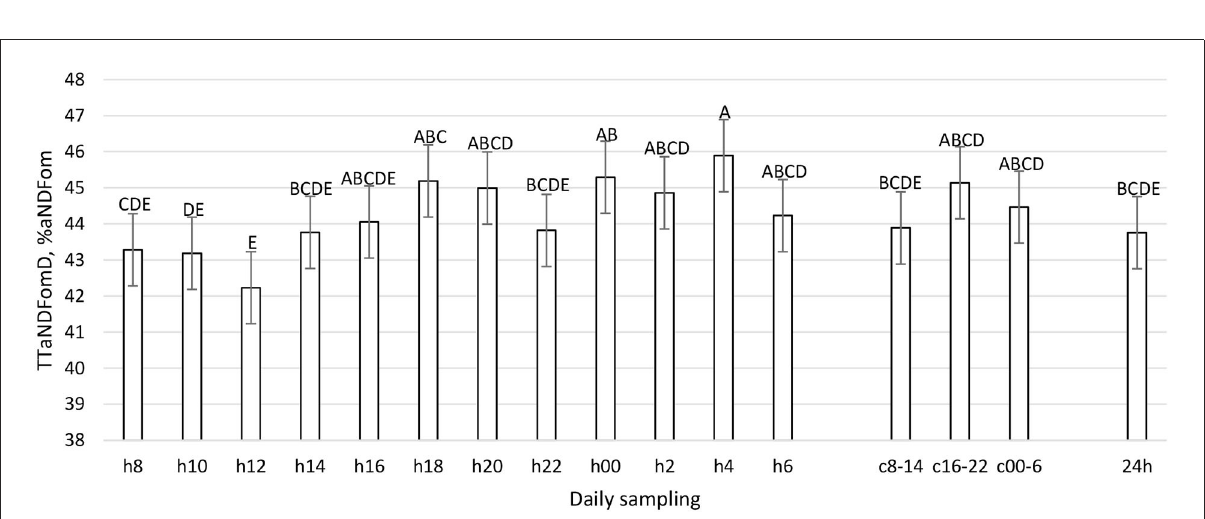
FIGURE11 Total Tract aNDFom Digestibility (%aNDFom) (LSM ± SE) in sampled time points (daily samplings: h8, h10, h12, h14, h16, h18, h20, h22, h00, h2, h4, h6; composites: c8-14, c16-22, c00-6, 24h). Letters for differences ≤ 0.05. P-value = 0.03; SEM = 0.74.